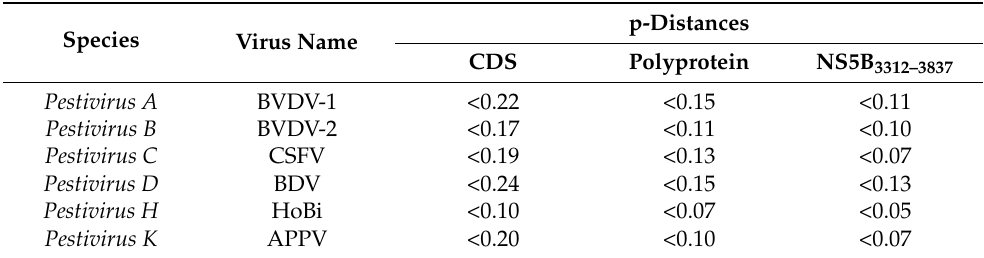
Table 4. Maximum p-distances between members of individual pestivirus species.